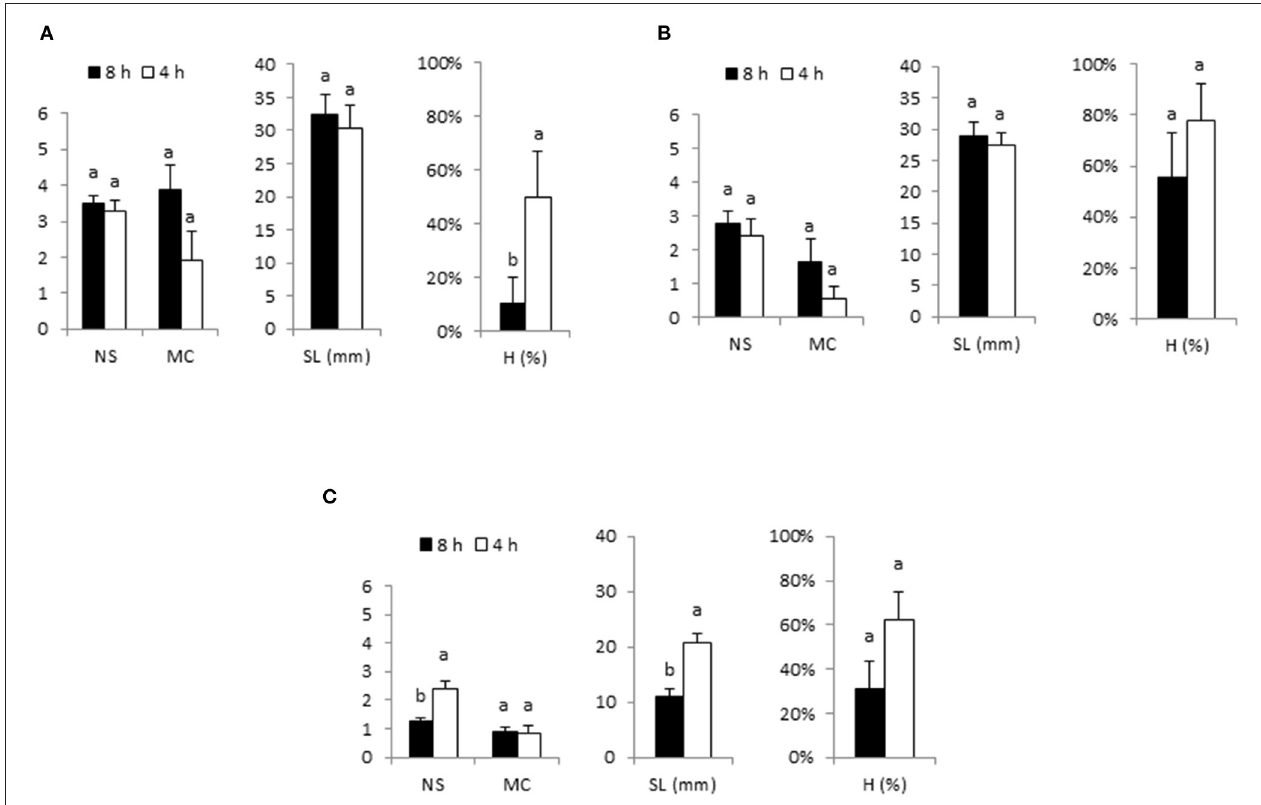
FIGURE 2 | Effect of immersion frequency (every 8 or 4h) on proliferation rates of apical sections of Beatriz (A) , Moniek (B) , and Mati (C) genotypes cultured in RITA ® vessels. Explants were grown in MS medium with half-strength nitrates and 2- µ M metatopoline. Immersion duration was set at 1min. Ten explants/RITA ® were used for Beatriz and Moniek and 16 explants/RITA ® for the Mati genotype. The data were recorded after 4 weeks of culture. The values represent the mean ± standard error. For each variable, different letters indicate significant differences at p < 0.05. NS, number of shoots per explant; MC, multiplication coefficient; SL, length of the longest shoot (mm); H, percentage of hyperhydric